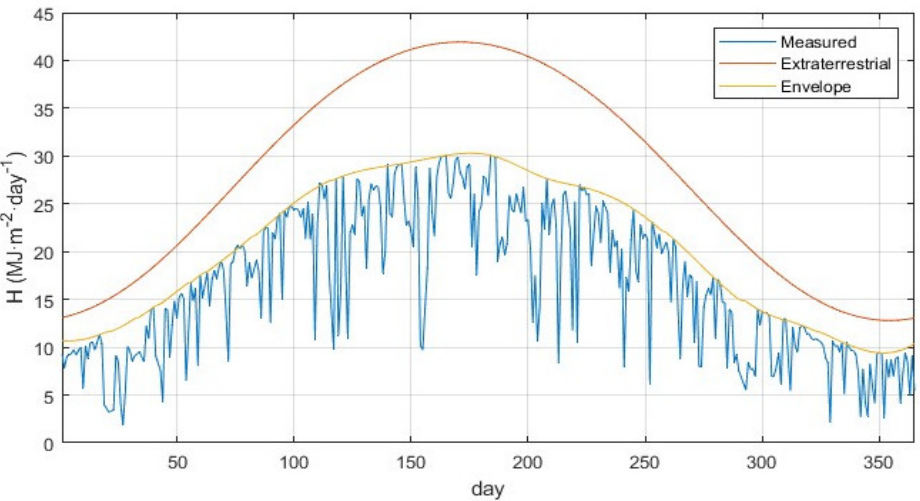
Figure 2. Comparison between the extraterrestrial radiation and the radiation registered on the earth’s surface at the REUS/AIRPORT station (S05) during 2018.